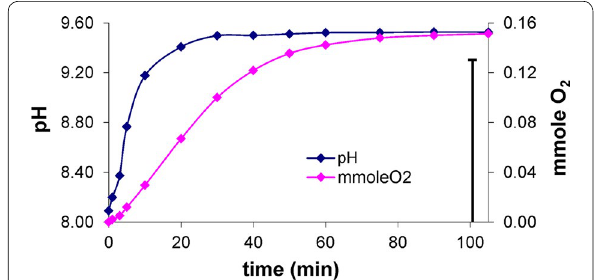
Fig. 2 The Co(II)– l -α-histidine–Himid system at molar ratio 0.3:0.75:0.3 (mmol). Dependence of pH and number of mmole O 2 bound on duration of the oxygenation reaction at a temperature of ~0°C (vertical segment corresponds to reversibility of O 2 uptake after saturation =